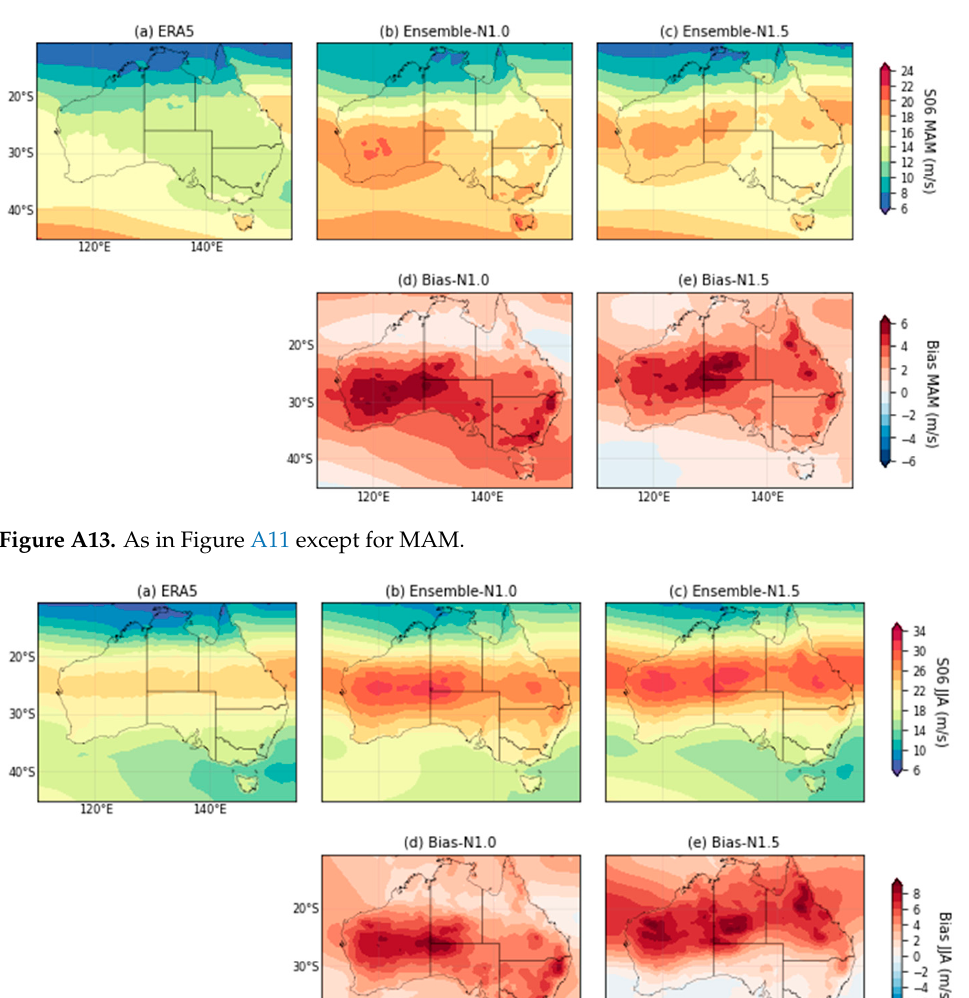
Figure A12. As in Figure A11 except for DJF.